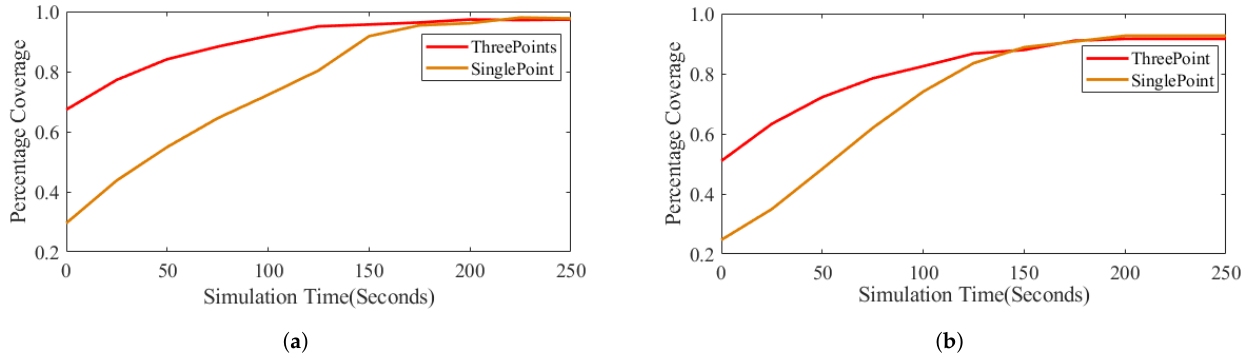
Figure 3. The average coverage rate during simulation time. ( a ) Deployment in obstacle free region. ( b ) Deployment in obstacle rich